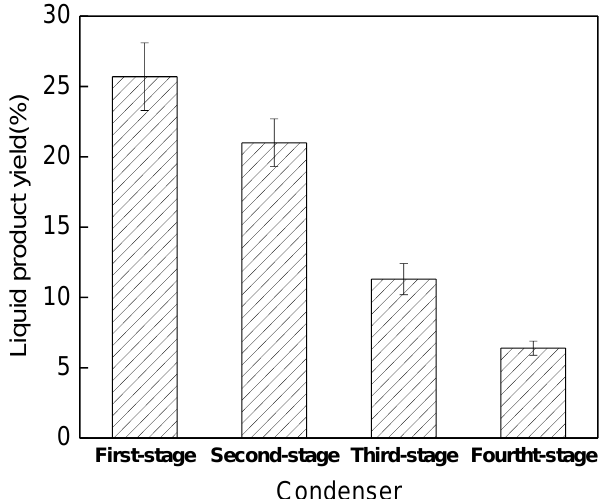
Figure 11. The liquid product yield collected by each condenser of the four-stage